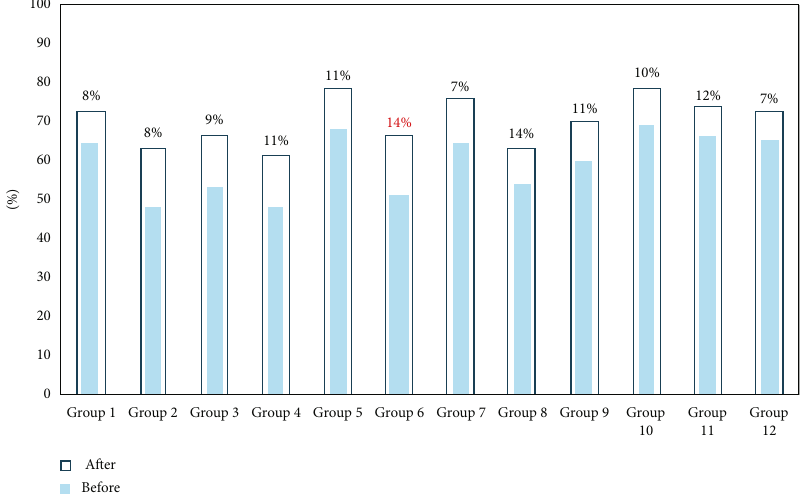
Figure 6: User satisfaction of intelligent question answering self-test system.